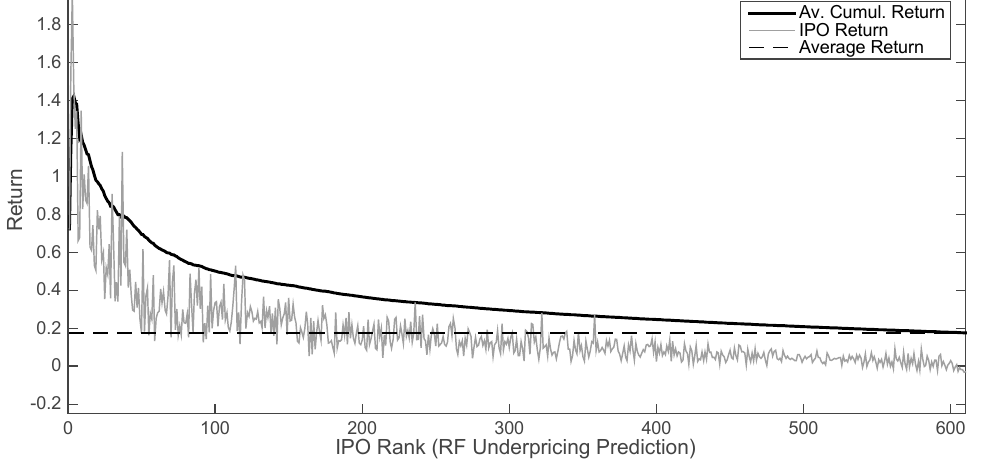
Figure 4. Return obtained investing according to the priorities set by the random forests (average over 15 runs on the test set). IPOs are ranked by the forecasted initial returns. Average cumulative return for rank n averages are the actual initial returns of the n highest ranking IPOs.